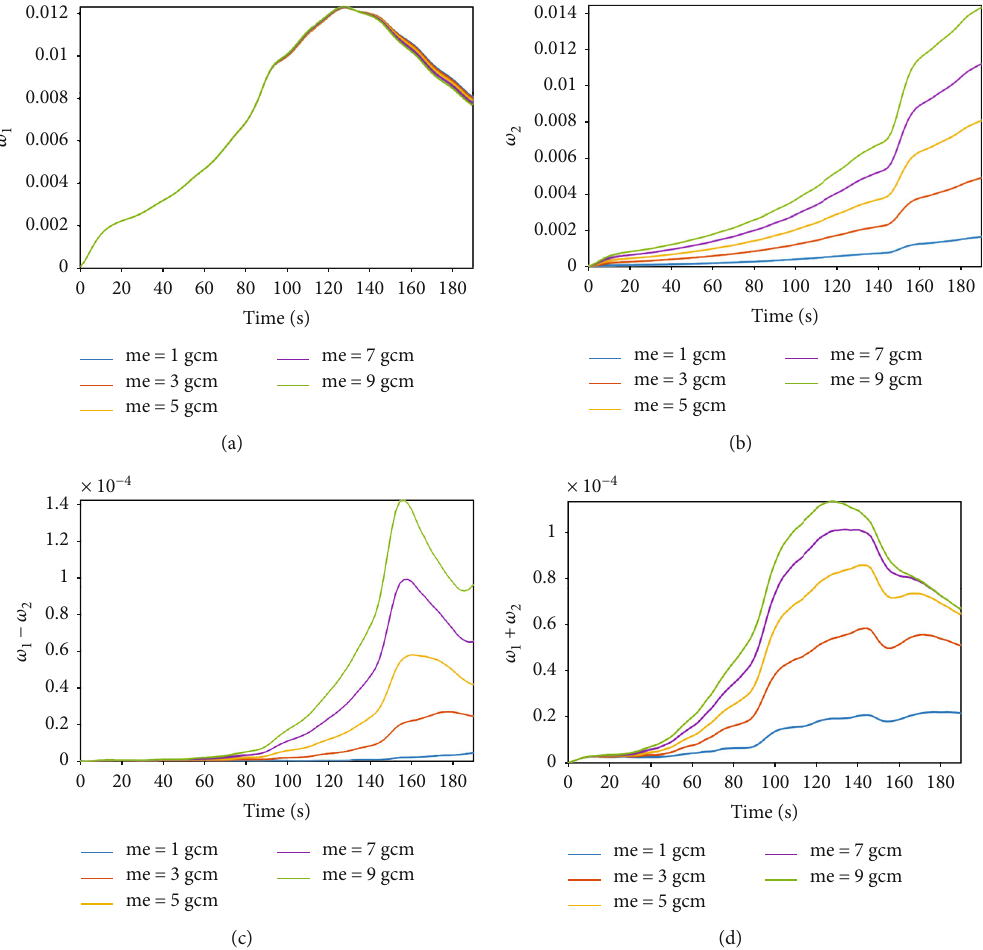
Figure 15: Responses at the analysis node of GG rotor with in fl uence of PT rotor unbalance: (a) ω